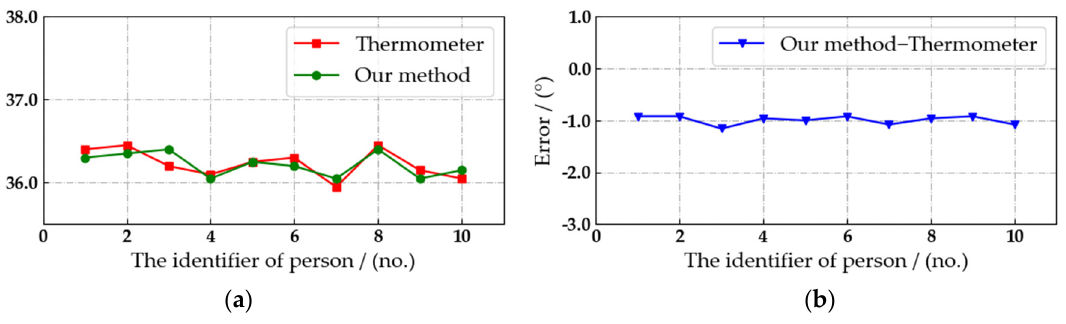
Figure 17. Comparison of pedestrian body temperature detection results at a distance of 3 m. ( a ) Temperature detection results. ( b ) Detection error.